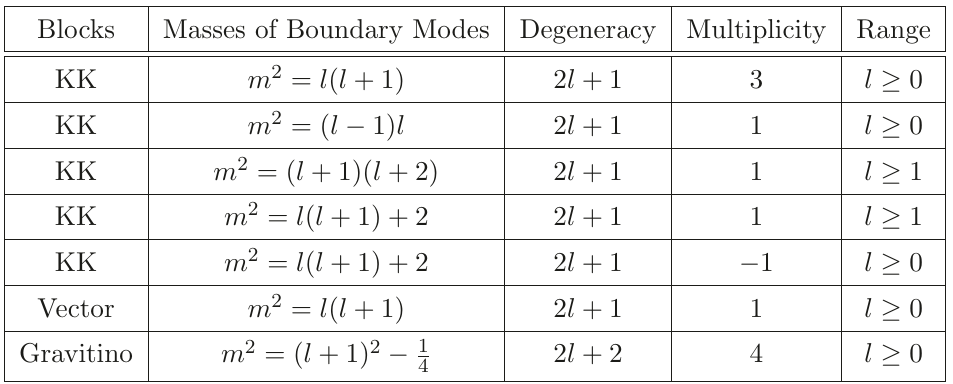
Table 3 . Mass spectrum of boundary modes in non-BPS blocks. (Multiplicity bution from